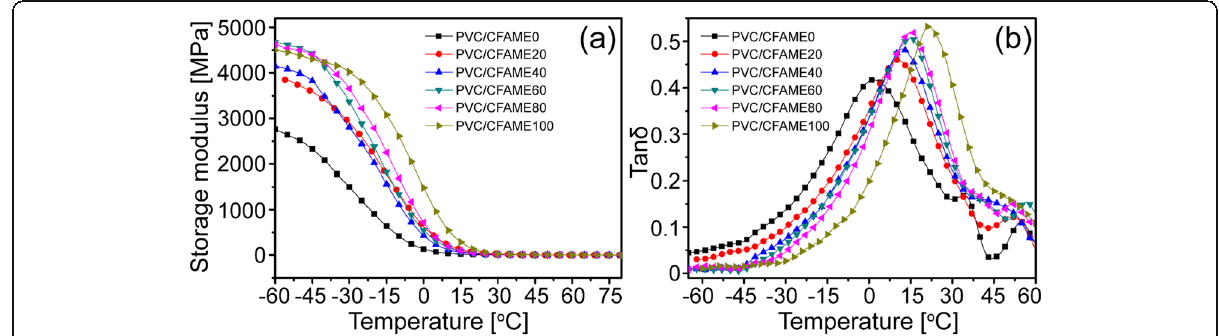
Fig. 4 a Storage modulus and b loss factor of PVC/CFAME x coatings as determined by DMA